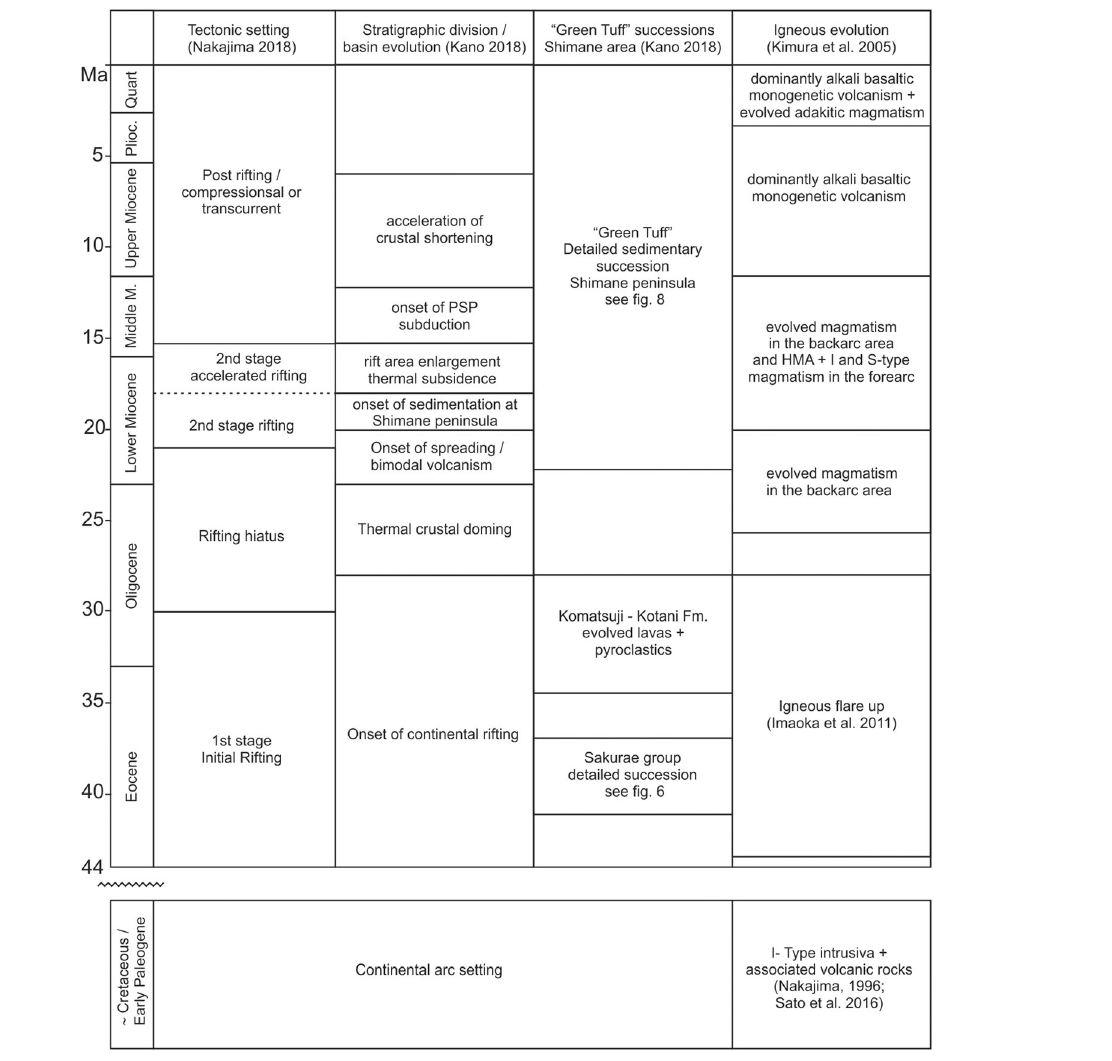
Table 1 Simplified stratigraphic table (with special emphasis on SW Japan) showing major tectonic events alongside with basin development and igneous activity which will be further discussed in the